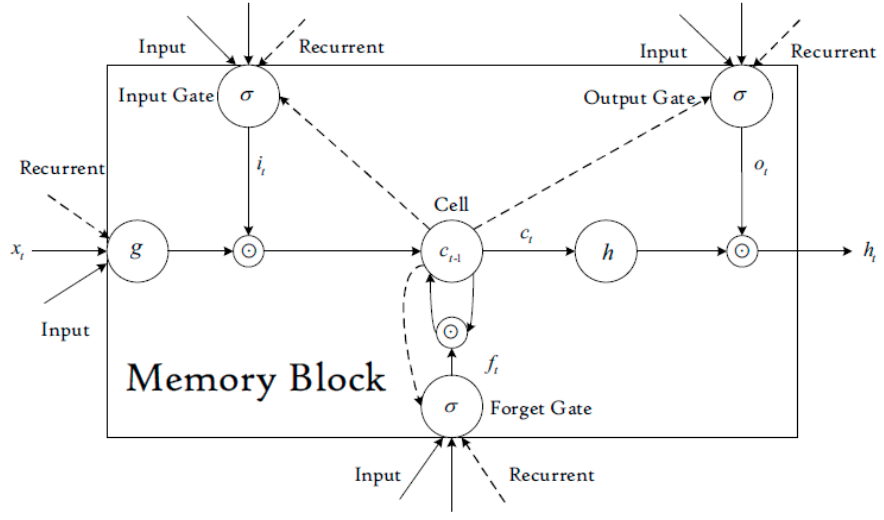
Figure 2. Framework of a Recurrent Neural Network: Input layer ( X t ); output layer ( O t ); hidden layer ( S t ); parameter matrices and vectors ( U, V, W ); activation function of output layer ( σ y ); and activation function of hidden layer ( σ h ) [65].